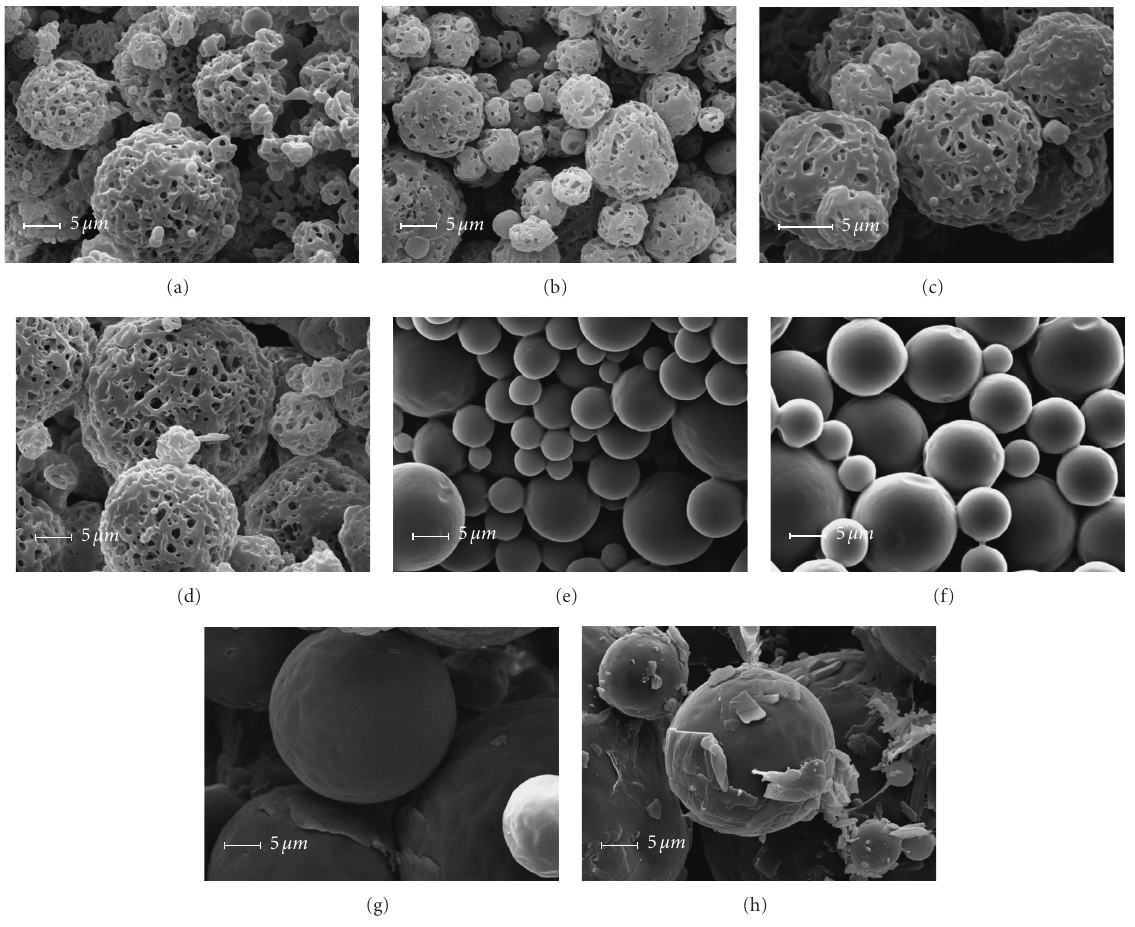
Figure 2: Scanning electron micrographs of PHBV/PCL microparticles: M1R0 (a), M1R5 (b), M1R10 (c), M1R20 (d), M2R0 (e), M2R5 (f), M2R10 (g), and M2R20 (h). Magnifications of